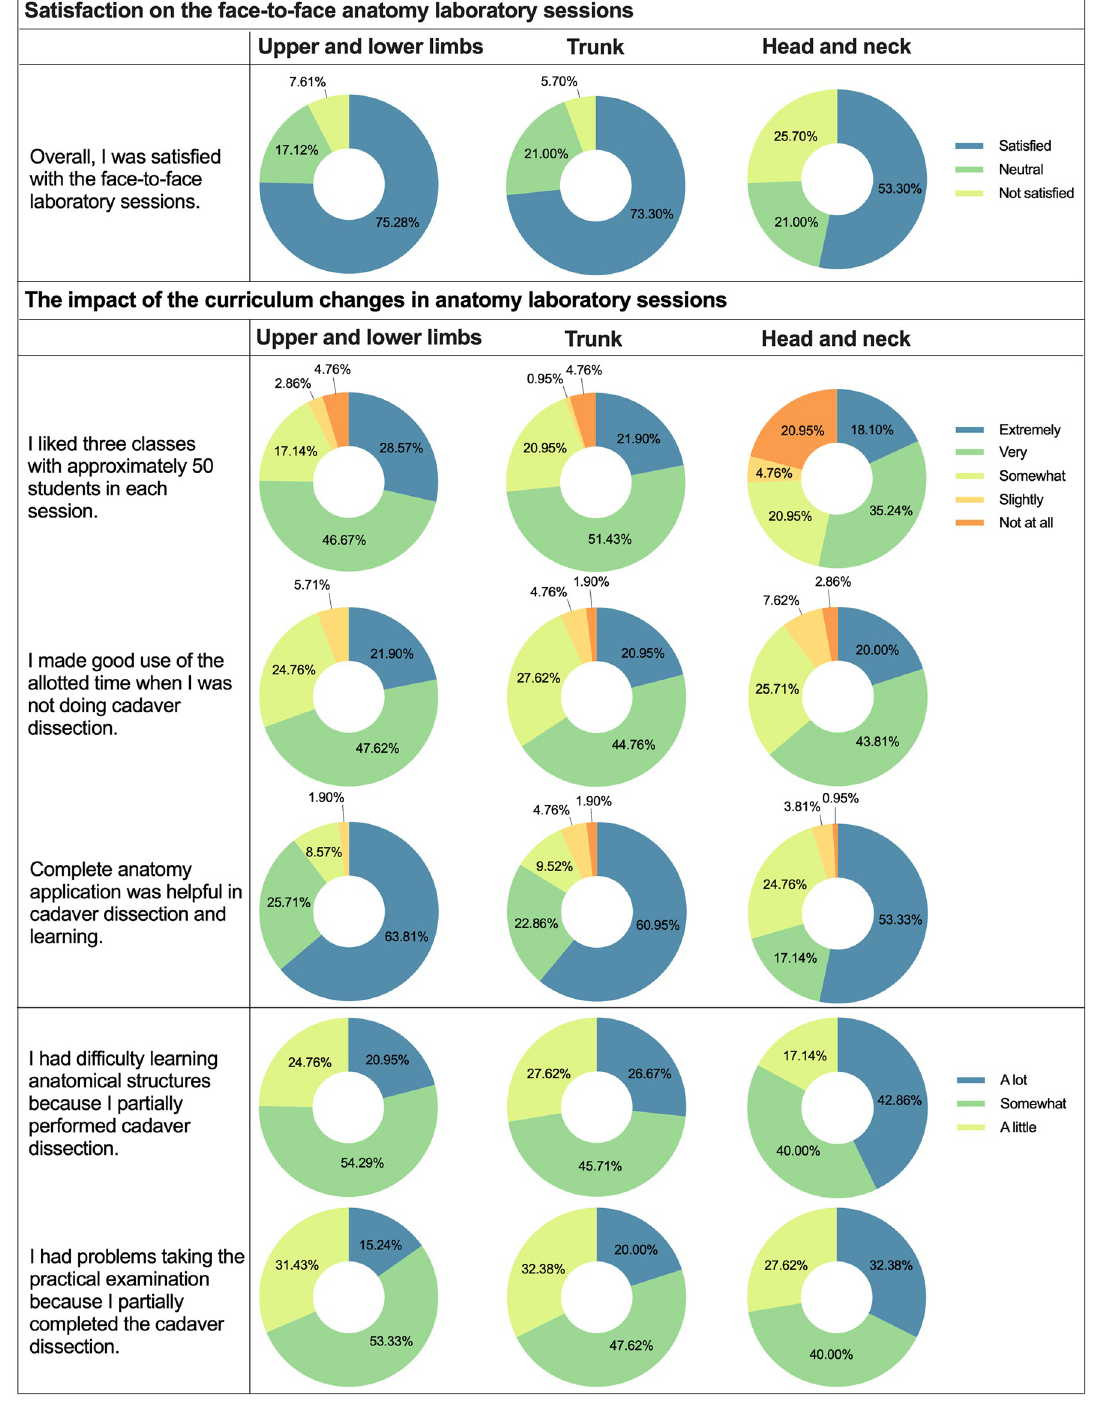
Fig 3. Students’ satisfaction on face-to-face anatomy laboratory sessions. Students’ (n = 105) satisfaction on face-to-face anatomy laboratory sessions was ranked on a 3-point Likert-type scale (1 = satisfied and 3 = not satisfied). Students were asked about the impact of the modified schedules and methods of teaching in anatomy laboratory sessions they experienced after the COVID-19 pandemic, as represented by pie graphs. The 3- and 5-point Likert scale scores are shown in percentage. Abbreviation: COVID-19 = coronavirus disease